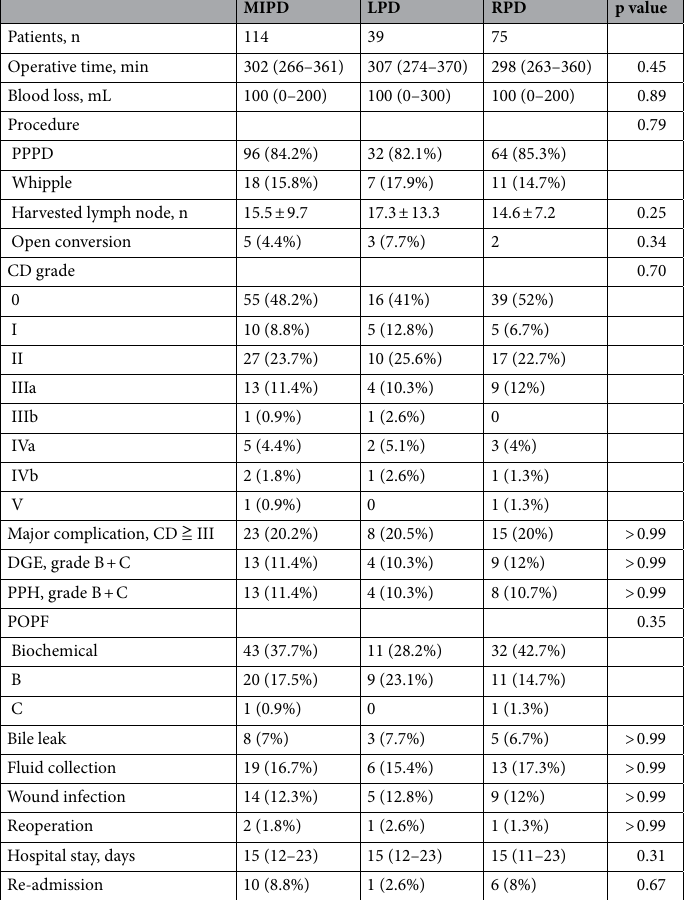
Table 2. Perioperative outcomes of MIPD. PPPD pylorus preserving pancreaticoduodenectomy, CD Clavien– Dindo, DGE delayed gastric emptying, PPH postpancreatectomy hemorrhage, POPF postoperative pancreatic